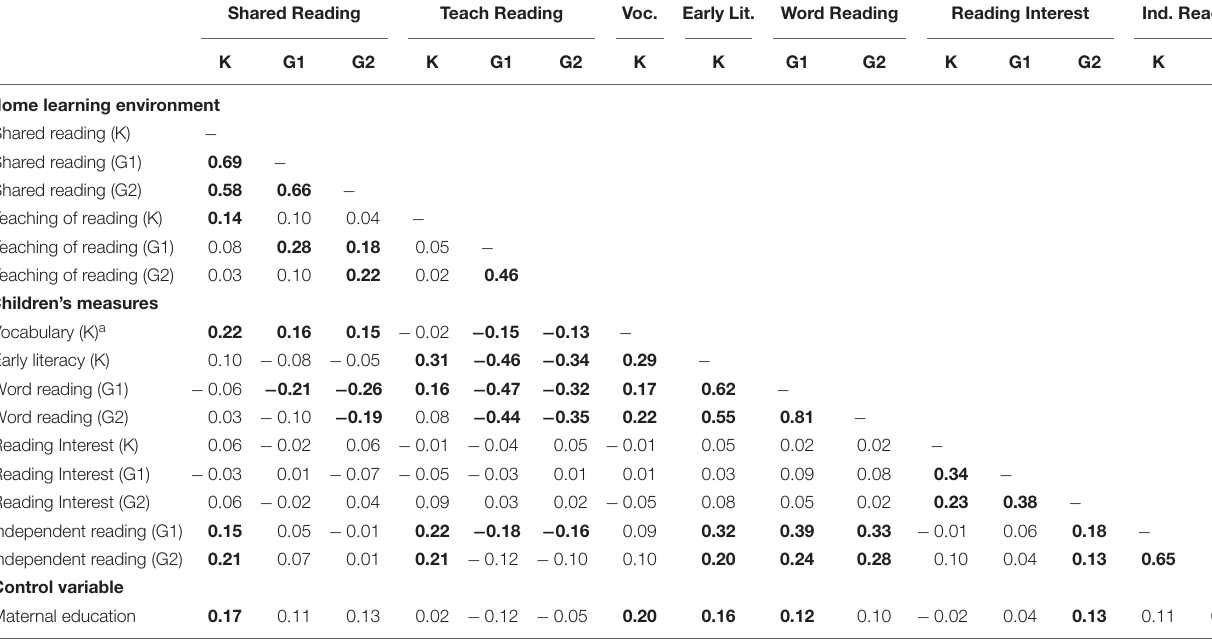
TABLE 2 | Concurrent and longitudinal correlations a among home literacy variables and child measures at the ends of kindergarten (K), Grade 1 (G1), and Grade 2 (G2). Shared